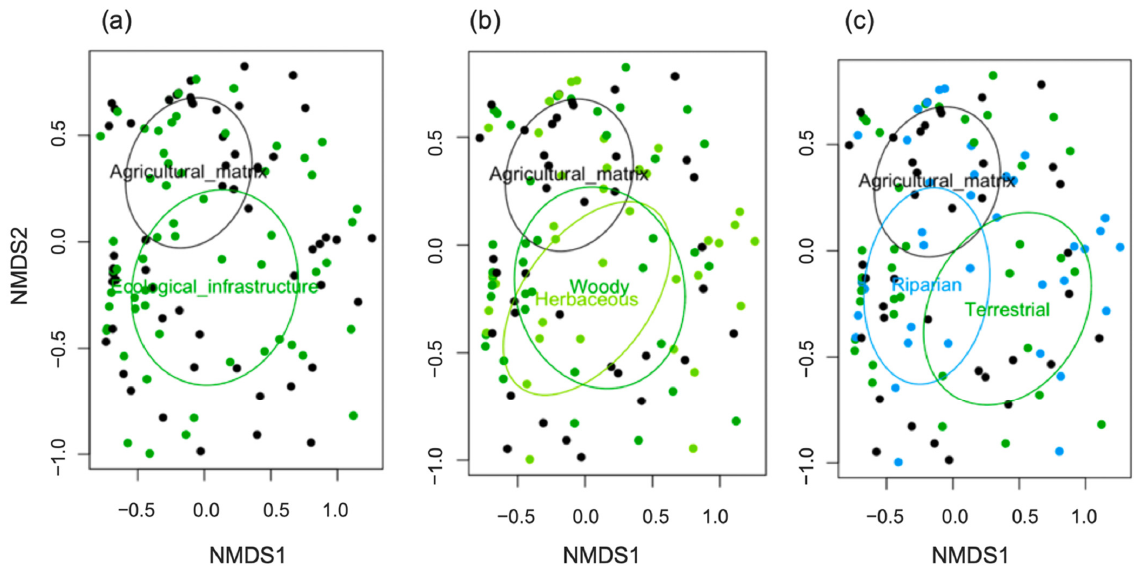
Figure 3. Ordination plots of species composition of ant communities in Ecological infrastructures (EI) and the agricultural matrix assemblages based on Bray–Curtis dissimilarities: ( a ) EI vs. agricultural matrices; ( b ) woody EI vs. herbaceous EI vs. agricultural matrices; ( c ) terrestrial EI vs. riparian EI vs. agricultural matrices Legend: EI—ecological infrastructures (green); MATRIX—agricultural matrix (black); W—woody EI (dark green); H—herbaceous EI (light green); T—terrestrial EI (green); R—riparian EI (blue).